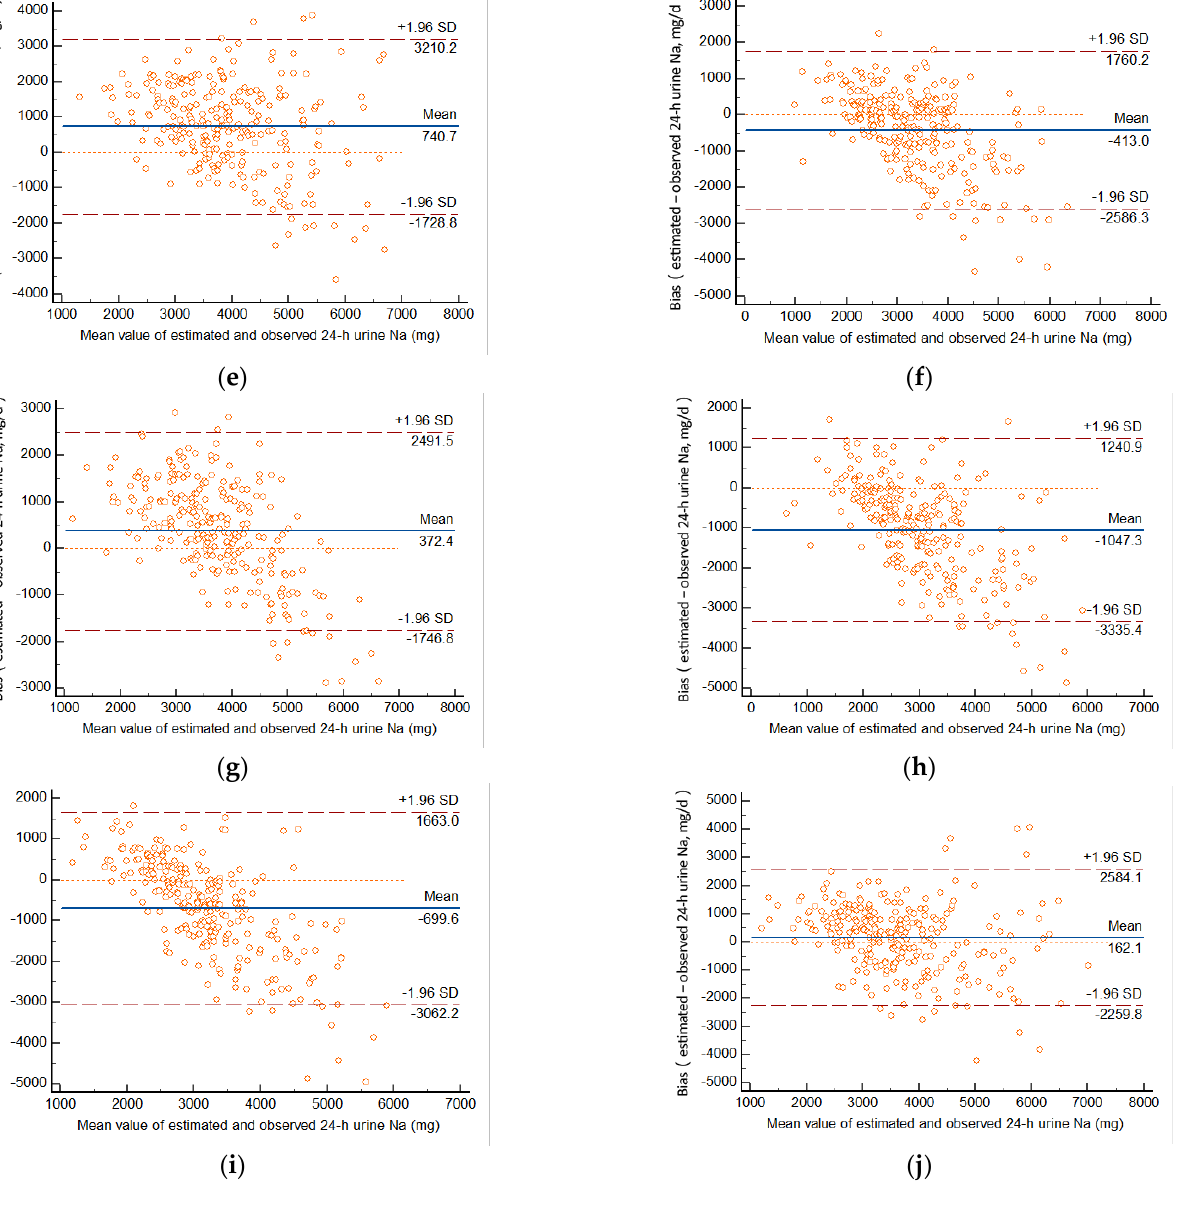
Figure 2. Bland – Altman plot of the bias (difference) between predicted and measured 24-h urinary sodium excretion in winter, based on INTERSALT equation ( a ) and Tanaka equation ( b ) in the morning, INTERSALT equation ( c ), Tanaka equation ( d ) and Sun’s equation ( e ) in the afternoon, INTERSALT equation ( f ) and Tanaka equation ( g ) in the evening, and INTERSALT equation ( h ), Tanaka equation ( i ) and Kawasaki equation ( j ) overnight.